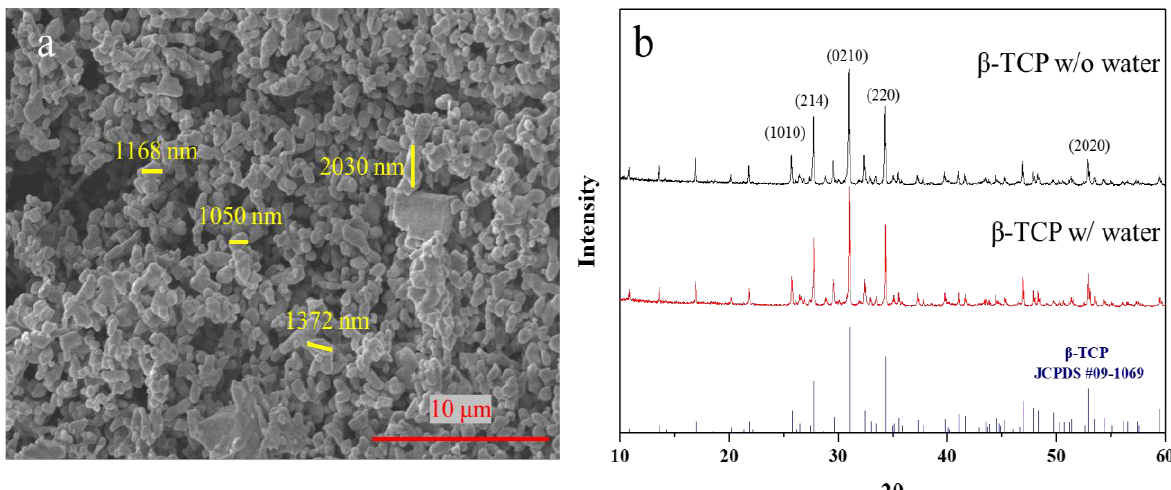
Figure 2. ( a ) X-ray diffraction analysis result of β -TCP powder (black for origin powder; red for soaked powder) and standard β -TCP peak. ( b ) Scanning electron microscope image of original β -TCP particles.